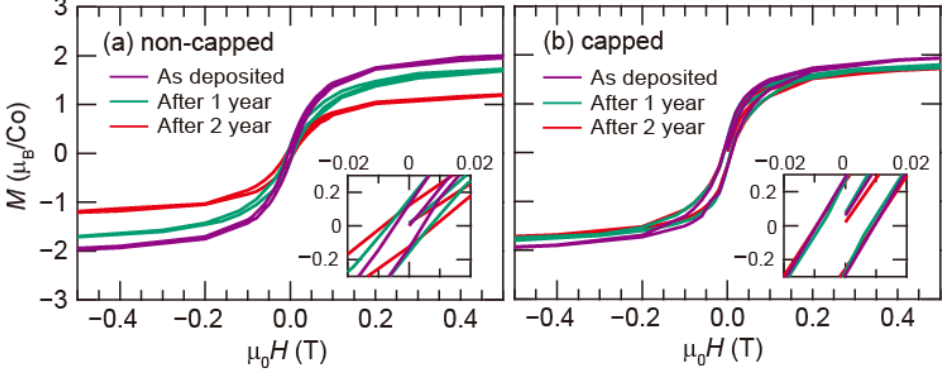
Figure 4. The aging of out ‐ of ‐ plane magnetization curves at 300 K for Ti 0.95 Co 0.05 O 2 −δ thin films ( a ) without a capping layer and ( b ) with a 2 ‐ nm ‐ thick capping layer. Insets denote magnified views at around a zero magnetic field.